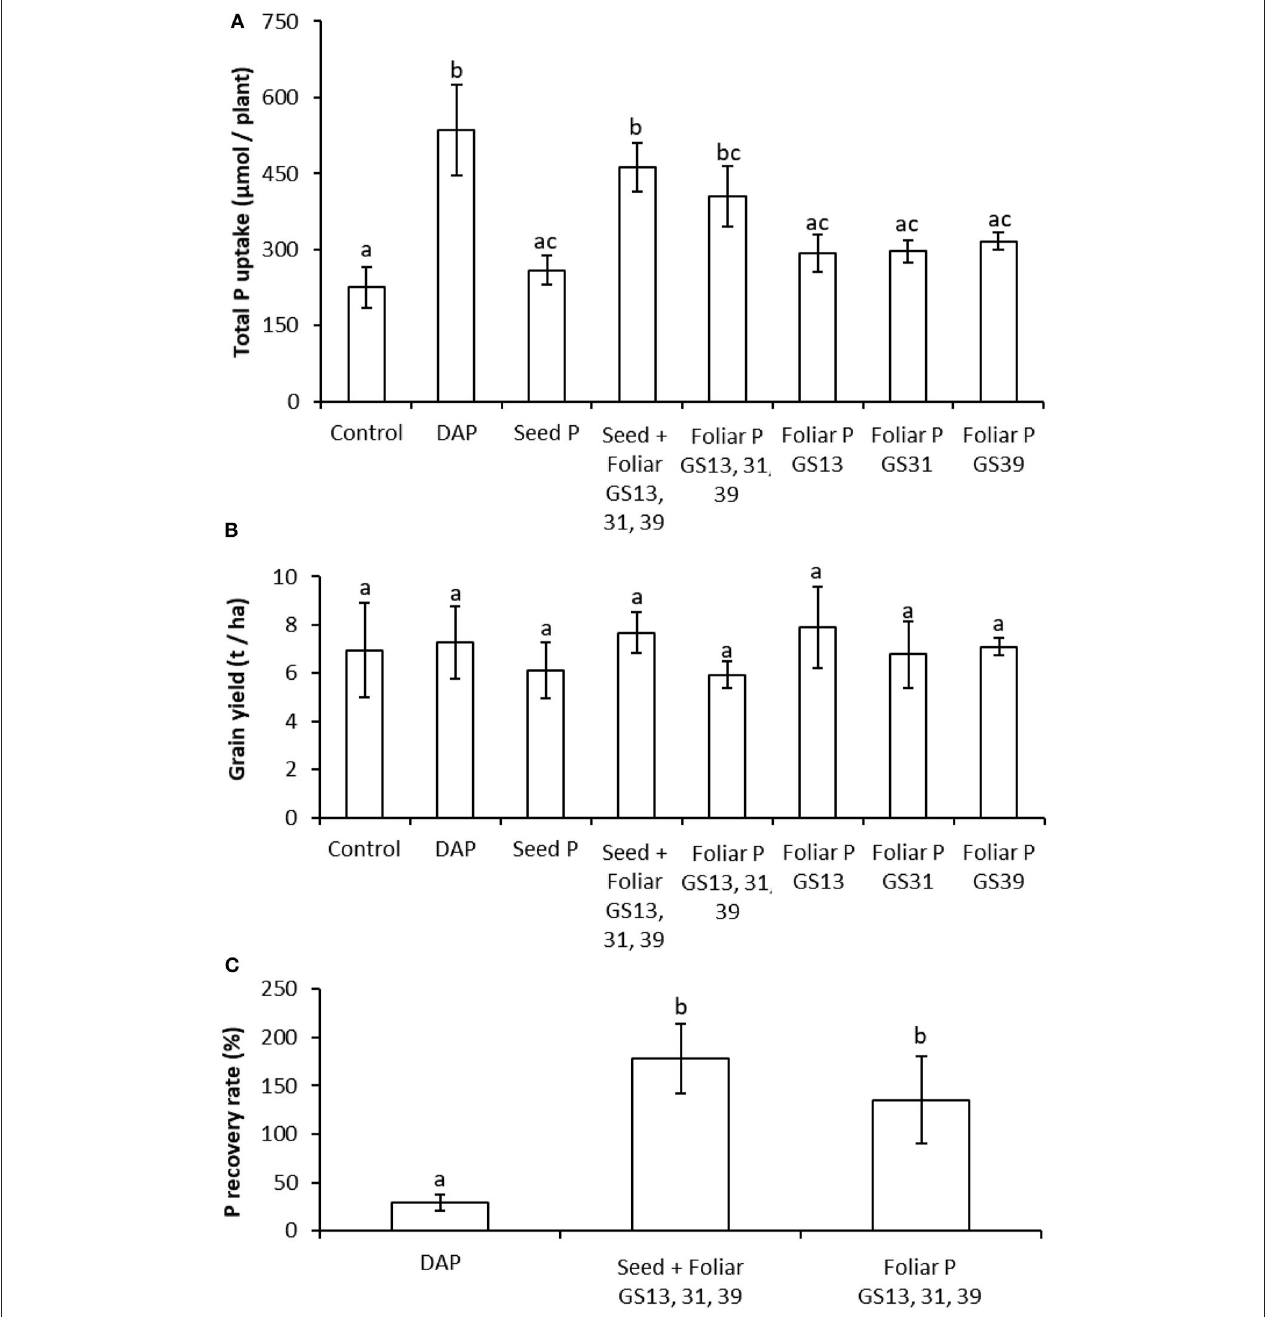
FIGURE 5 | Combining foliar P application with seed P dressing can produce comparable yields of Triticum aestivum to soil P fertilization with greater P recovery rates over the untreated control in P-sufficient conditions. Panel (A) : Total P content of wheat plants grown to maturity in 3kg sandy loam soil. P-fertilization treatments were untreated controls, di-ammonium phosphate (DAP) granules placed in soil (885 µ mol P plant − 1 ); single or triple applications of foliar P (46.3 µ mol P plant − 1 application − 1 ); seed dressings (3 µ mol P plant − 1 ) combined with three foliar applications (46.3 µ mol P plant − 1 application − 1 ). Panel (B) : Grain yields scaled to t ha − 1 for the treatments reported in (A) . Panel (C) : Recovery rates of the applied P in the whole plant for the treatments that produced significant differences to the control in (A) . Values represent means ± SEM ( n = 4) with lowercase letters showing significant differences between treatments ( p < 0.05; one-way